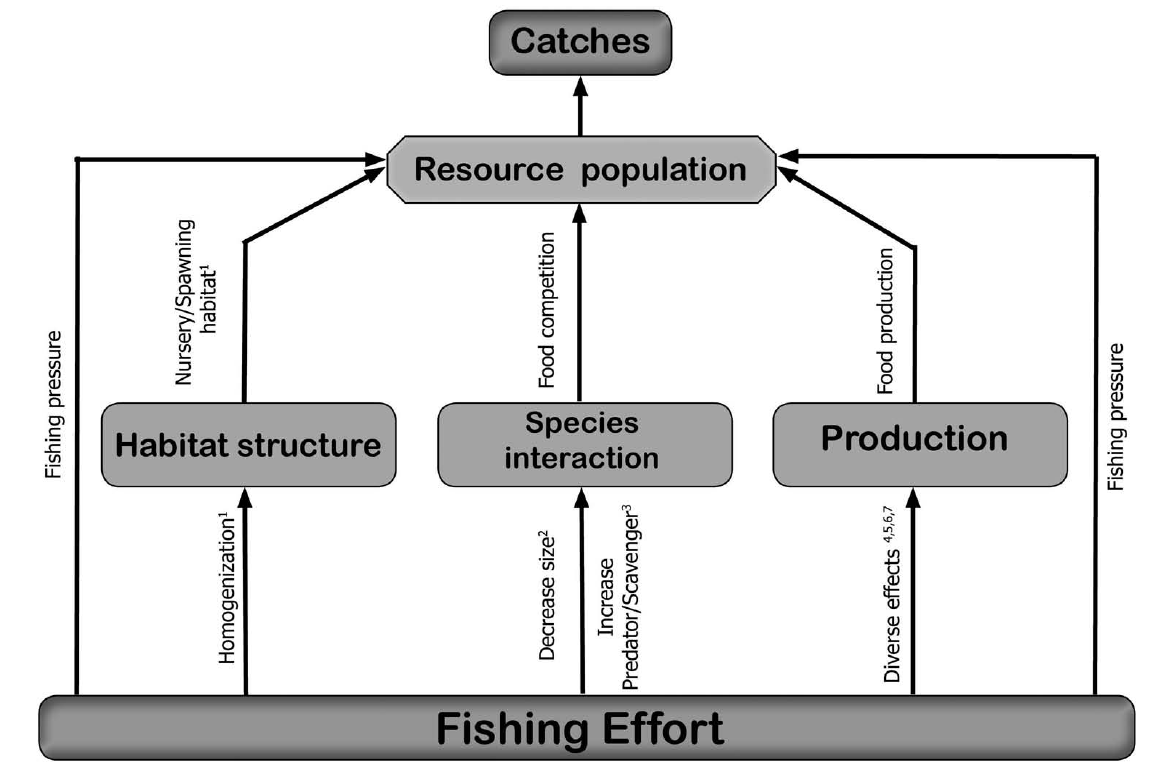
Fig. 1. – Conceptual model depicting the effects of fishing on commercial species. See the text for more details. References: 1 Jennings and Kaiser 1998, 2 de Juan et al. 2009, 3 Rumohr and Kujawski 2000, 4 Jennings et al. 2001, 5 Jennings et al. 2002, 6 Queirós et al. 2006, 7 Hiddink et al.